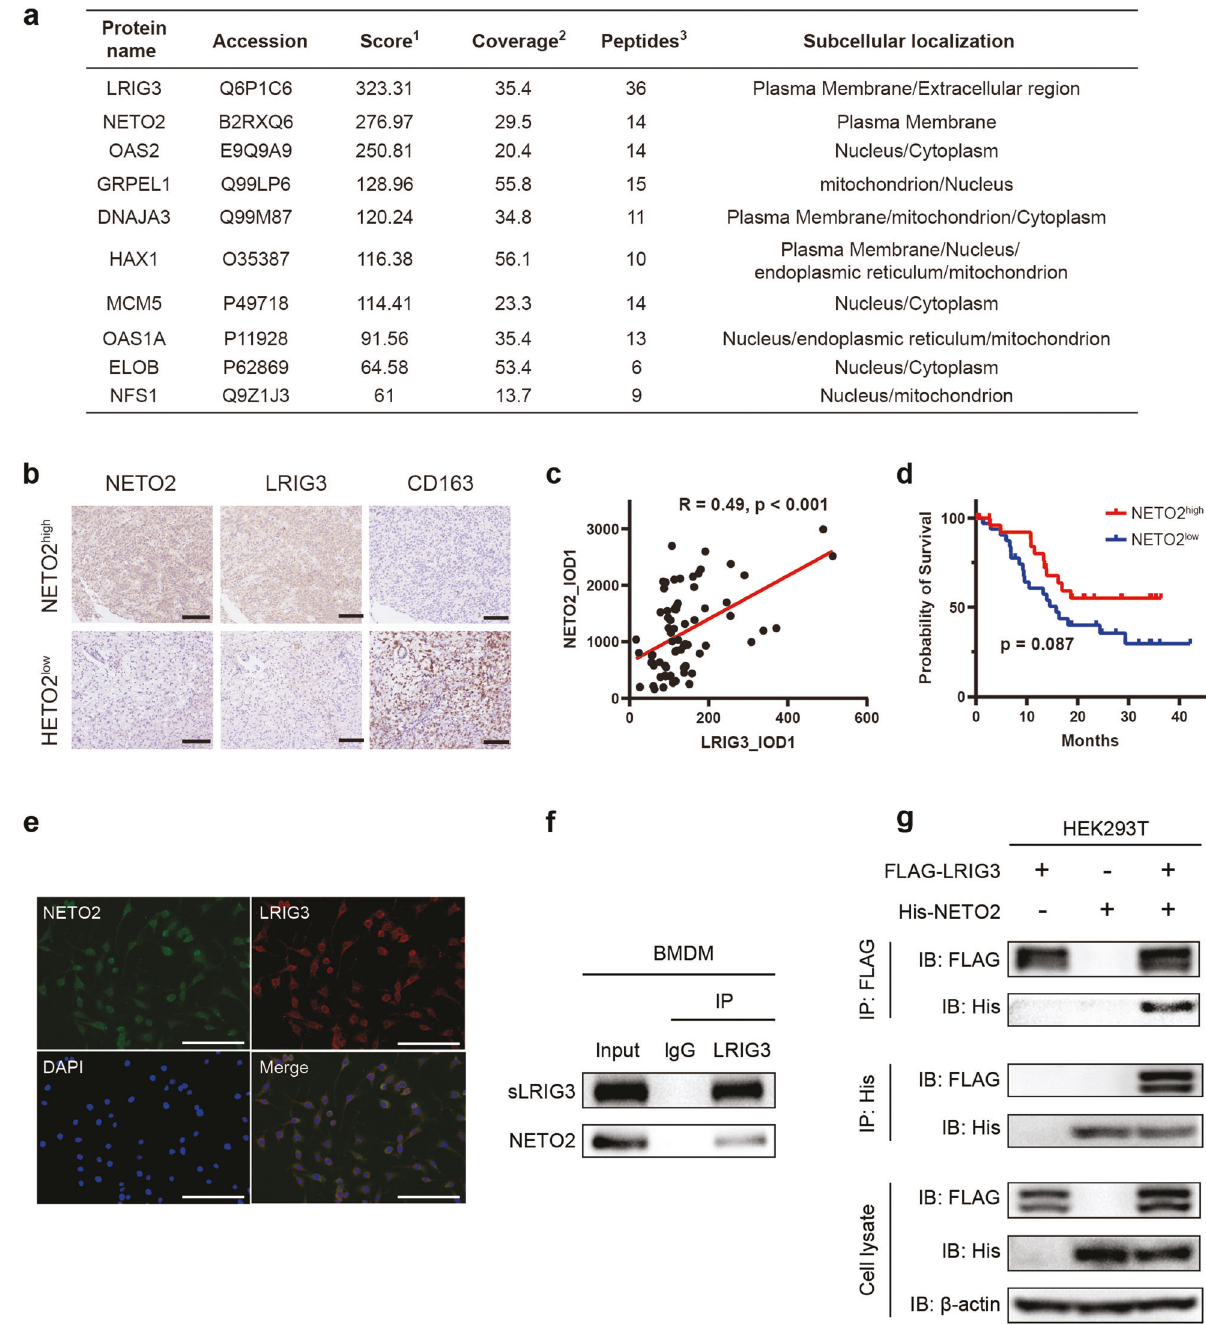
Fig. 4 Discovery of sLRIG3-interacting protein NETO2 in TAMs of GBM. a Top candidates of soluble LRIG3 interacting proteins identi fi ed by pull-down and mass spectrometry analysis. 1 Score: Protein scores, calculated by Proteome Discoverer application from a list of peptides identi fi ed for a particular protein, indicate the relevance of a protein. 2 Coverage: Coverage of identi fi ed high-con fi dence peptides match the protein. 3 Peptides: Number of high-con fi dence peptides which match the protein. b Representative images of the low- and high-expression levels of NETO2, LRIG3, and CD163 in human GBM tissue microarrays. Scale bar, 50 μ m. c Correlation analysis between LRIG3 and NETO2 expression in TMA ( n = 35) of GBM. Pearson ’ s correlation test. d Kaplan – Meier survival curves of NETO2-High-expression and NETO2-Low- expression patients in TCGA GBM database. Log-rank test. e Representative immuno fl uorescence for NETO2 (green) and LRIG3 (red) in BMDM- derived TAMs. Scale bar, 50 μ m. f Co-immunoprecipitation of NETO2 with the LRIG3-speci fi c antibody from cell lysates of BMDM-derived TAMs treated with sLRIG3( + ) CM. Precipitation with normal mouse IgG was used as a negative control. g Co-immunoprecipitation of FLAG-LRIG3 and His-NETO2 from cell lysates of HEK293T transduced with pLVX-FLAG-LRIG3 and pcDNA3.1-His-NETO2. Precipitation with normal mouse IgG was used as a negative